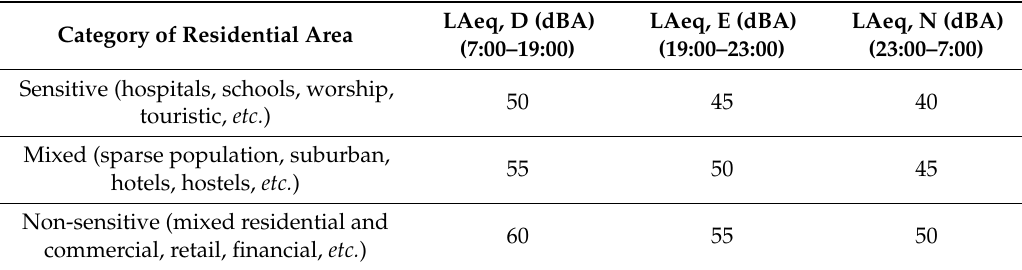
Table 1. Saudi standards for community